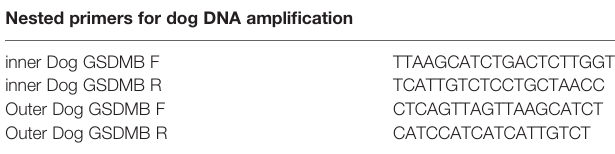
TABLE 2 | The nested primers used in dog DNA ampli fi